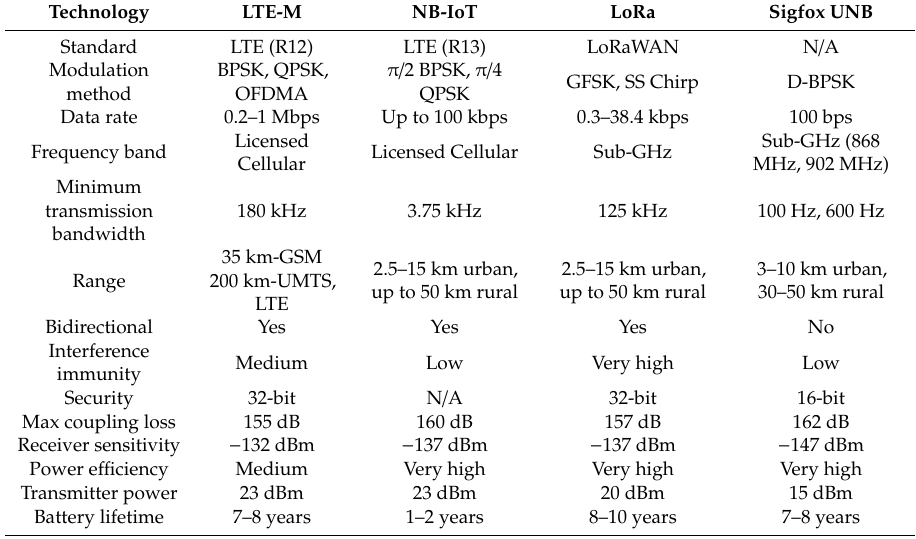
Table 1. Summary of leading LPWAN technologies. Orthogonal frequency-division multiplexing access (OFDMA); di ff erential BPSK